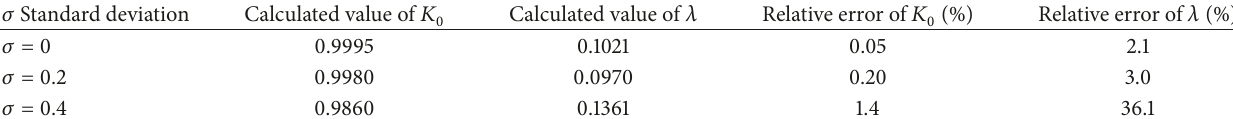
Table 4: The value of 𝐾 0 , 𝜆 and the average relative error.